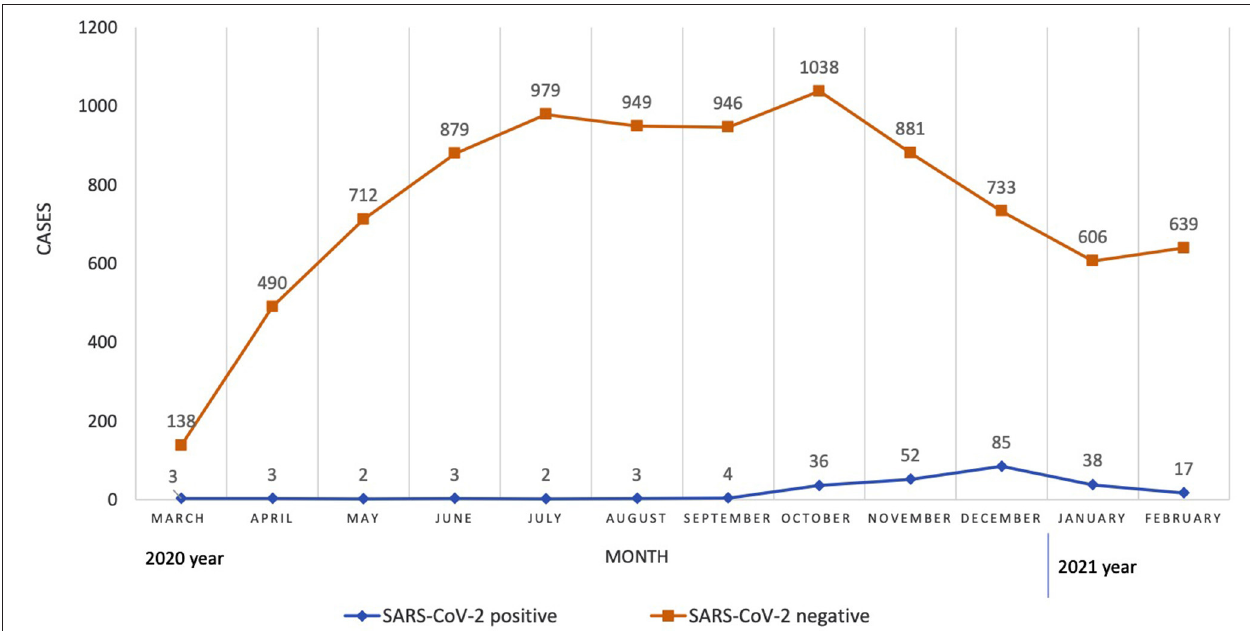
FIGURE 2 | Distribution of SARS-CoV-2-positive and SARS-CoV-2-negative cases on a monthly basis.